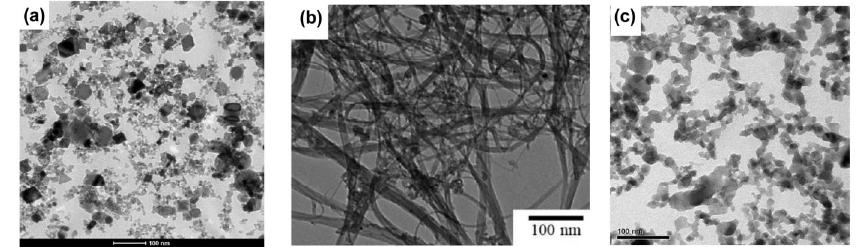
Fig. 1 TEM images of (a) alumina, (b) MWCNT nanofluid, and (c) Al-MWCNT hybrid